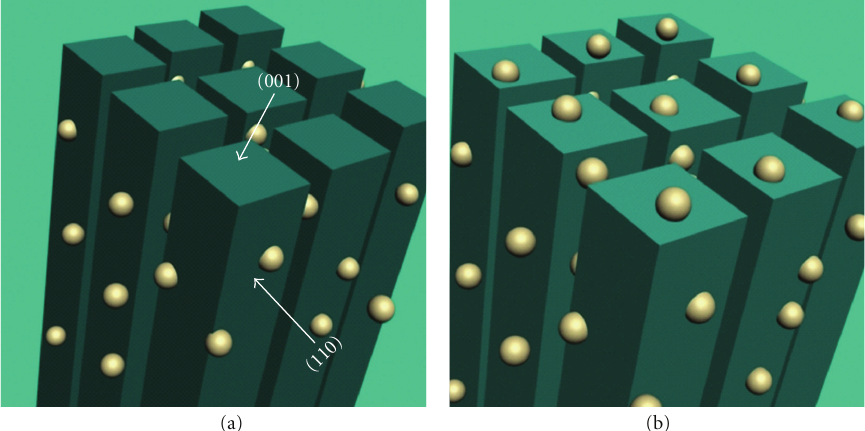
Scheme 1: Pictures illustrating the loading of Pt onto TiO 2 microspheres: (a) < 0.85wt% Pt and (b) > 0.85 wt% Pt.